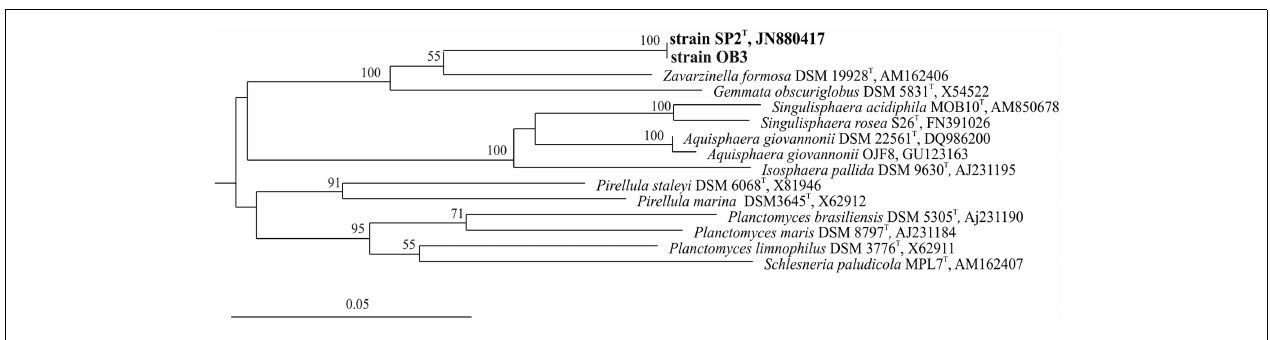
FIGURE 2 | 16S rRNA gene-based neighbor-joining tree showing the phylogenetic position of strains SP2 T and OB3 in relation to taxonomically characterized members of the phylum Planctomycetes . The root (not shown) was composed of five 16S rRNA gene sequences from anammox planctomycetes (AF375994, AF375995, AY254883, AY257181, AY254882).The scale bar represents 0.05 substitutions per nucleotide